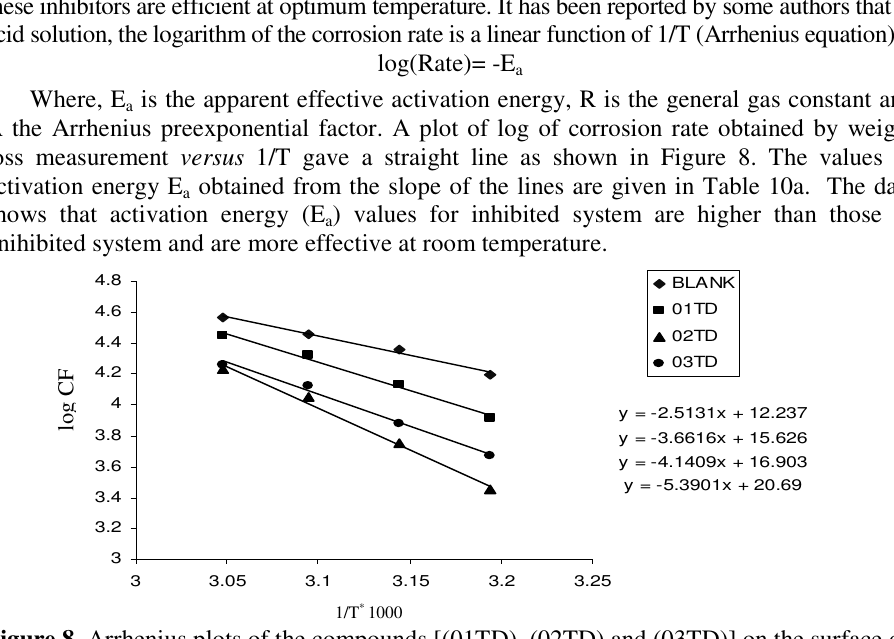
Figure 8. Arrhenius plots of the compounds [(01TD), (02TD) and (03TD)] on the surface of SO mild steel in 1 M H 2 4